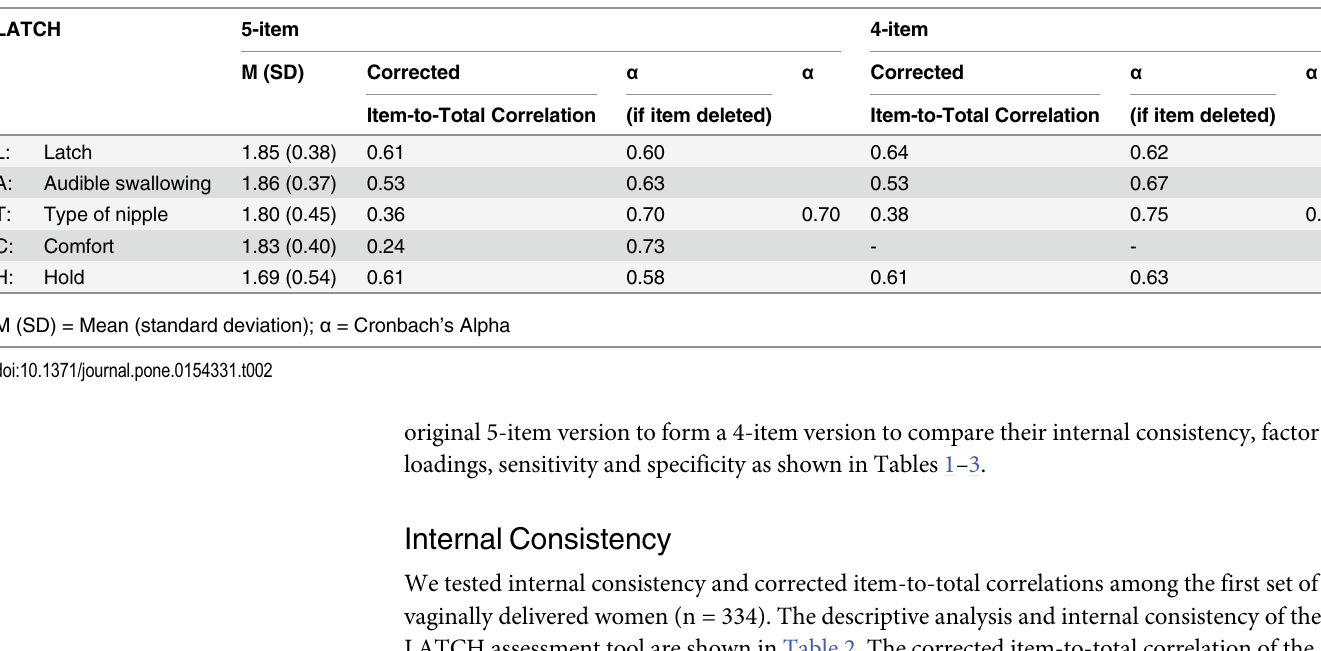
Table 2. Descriptive statistics and reliability tests of the 5- and 4-item LATCH breastfeeding assessment tools among vaginally delivered women (n = 334).